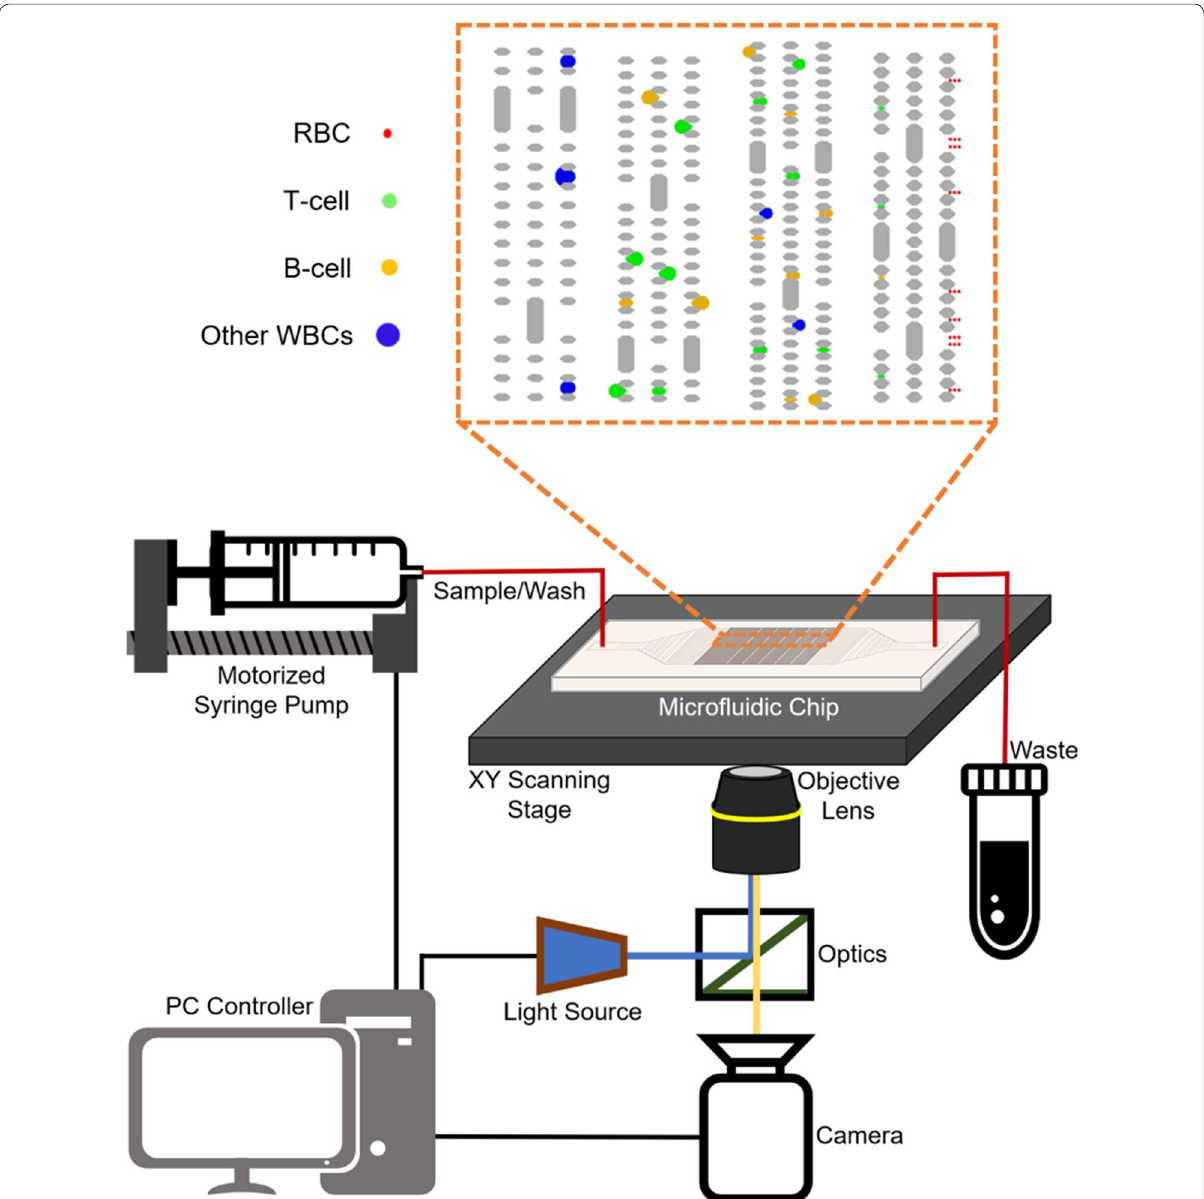
Fig. 1 Overview of the experiment setup. Blood is pumped into the device via inlet port. Due to the difference in size and deformability, leukocytes will be trapped in different